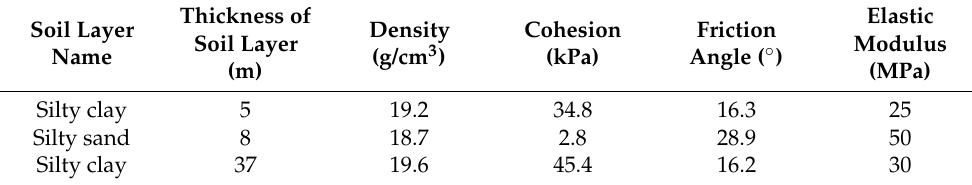
Table 2. Physical and mechanical parameters of simplified soil